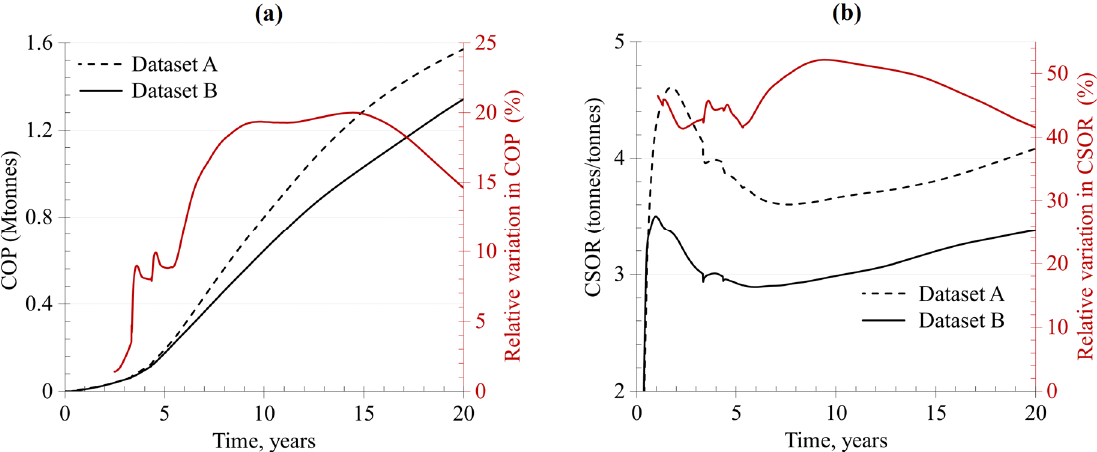
Figure 11. Comparison results for ( a ) cumulative oil production and ( b ) cumulative steam/oil ratio, calculated with the data on rock thermal properties taken from open sources (dataset A) and the results of our experimental studies (dataset B). Right axis (red) reflects the discrepancy in the results obtained with dataset A relative to the results based upon the experimental data.